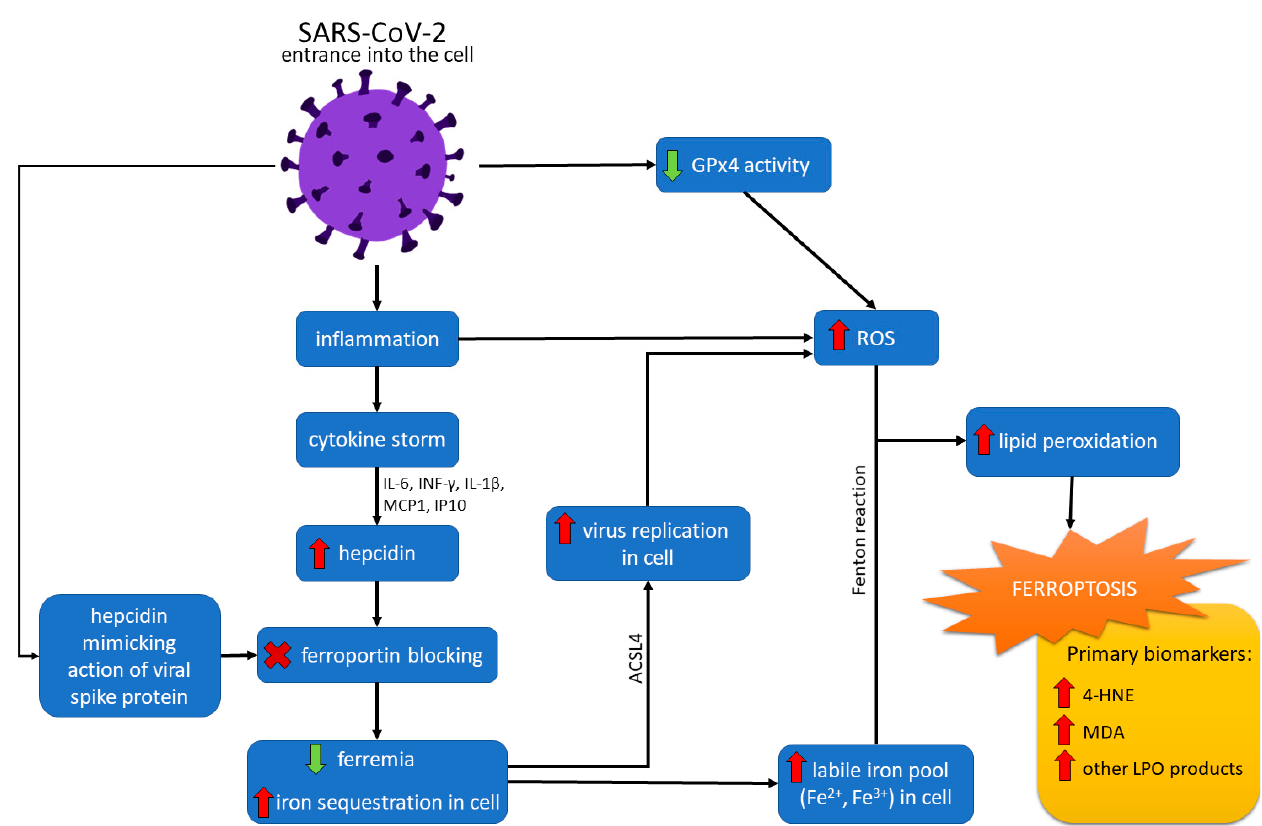
Figure 2. Ferroptosis pathways in SARS-CoV-2 infection. After entering the cell, the SARS-CoV-2 virus causes an inflammatory state, resulting in a cytokine storm. The effect of the cytokine storm, mediated with interleukin 6 (IL-6), interferon-gamma (IFN- γ ), interleukin 1-beta (IL1- β ), interferon- inducible protein 10 (IP10), and monocyte chemotactic protein 1 (MCP1) is an increased level of hepcidin. The action of hepcidin is downregulating ferroportin and determining hypoferremia and increased sequestration of iron in the cell. The virus can also imitate hepcidin action by a spike protein. Increased cellular iron level and catalytic activity of acyl-coenzyme A synthetase long-chain family member 4 (ACSL4) promotes virus replication and increases reactive oxygen species (ROS) formation. Downregulated action of GPx4 caused by the virus also leads to increased ROS produc- tion. Moreover, high cellular iron concentration can form free radicals through Fenton and Haber- Weiss reactions. ROS reacting with lipids increase lipid peroxidation (LPO), which finally causes ferroptosis.